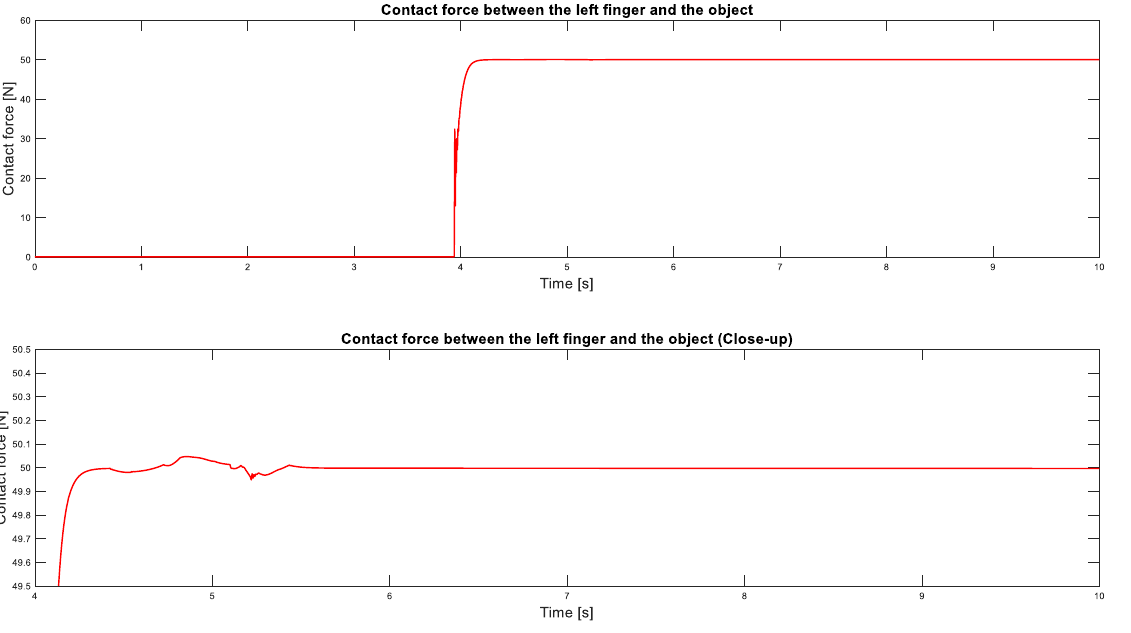
Figure 8. Selected contact force response (red line) between the left robotic finger and the object to be picked for a sample pick-point, F d = 50 N. Source: own.